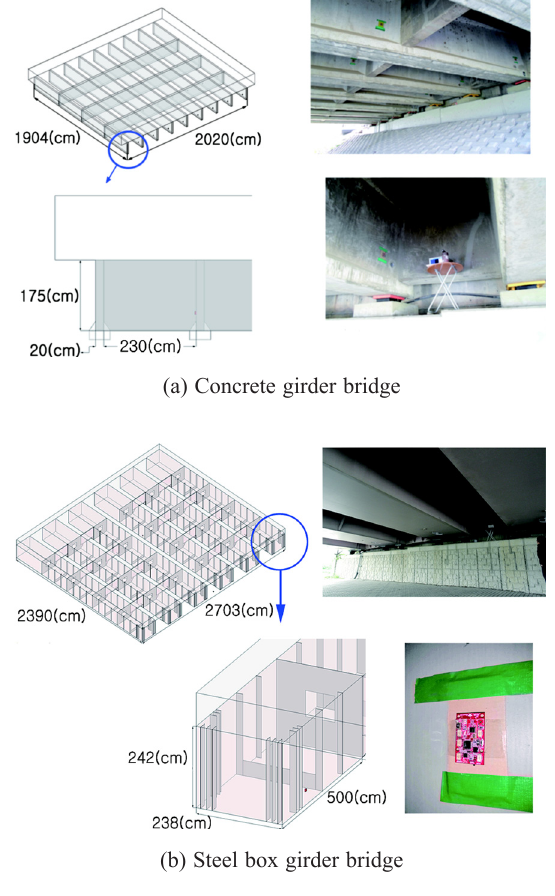
Fig. 4. Detail drawings of each bridge